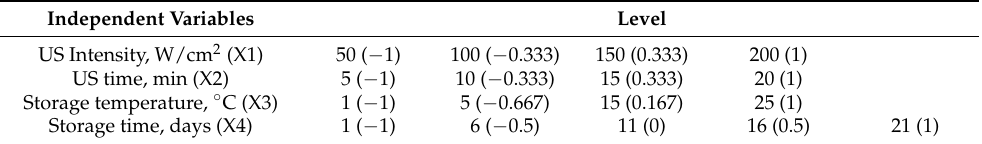
Table 2. Independent variables and their level used for central composite